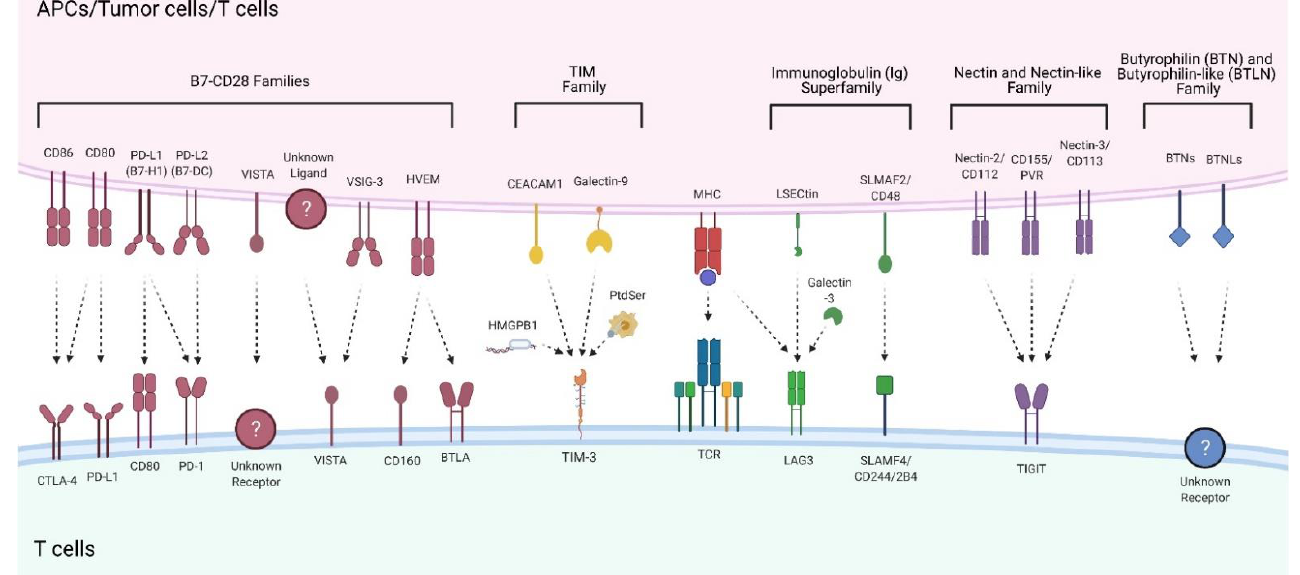
Figure 2. Overview of immune checkpoint molecules/co-inhibitory receptors causing immunosuppressive conditions in the TME. Different immune checkpoint molecules are expressed on T cells and are shown with their ligands expressed on APCs/tumor cells and/or T cells triggering a co-inhibitory signal to suppress effector T cell responses. Immunosuppressive mechanisms are described in detail below. Created with BioRender.com.